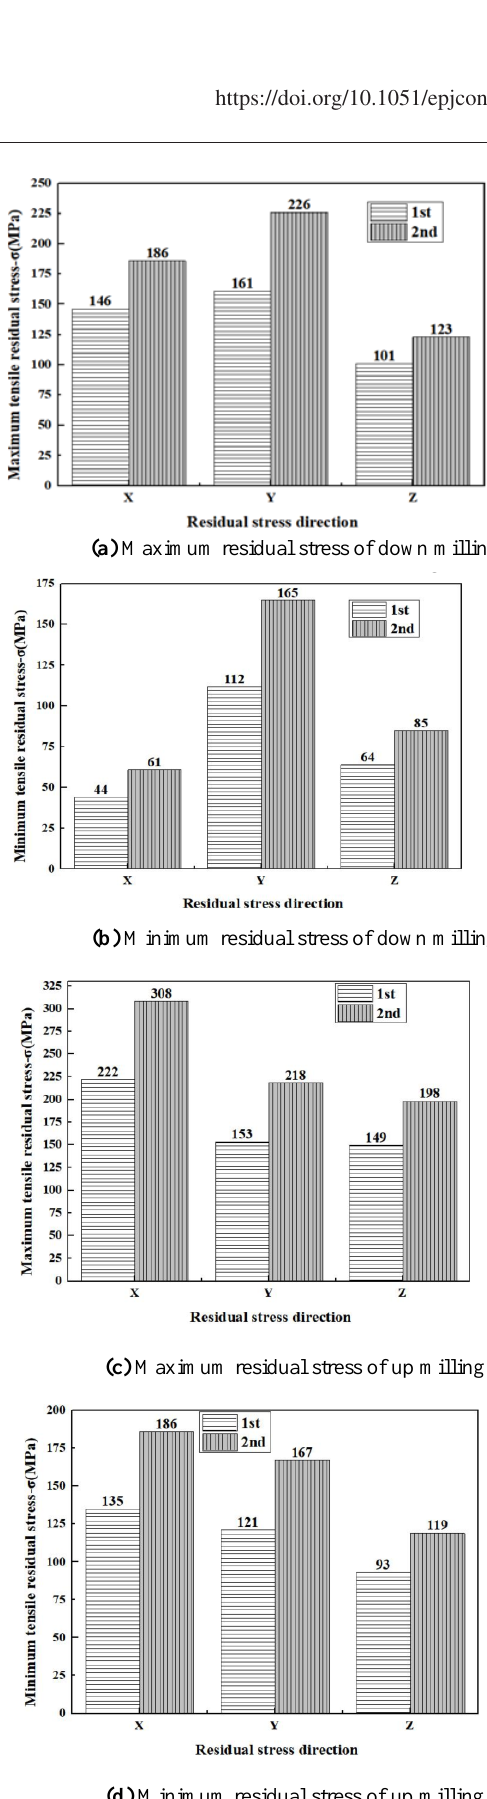
Fig.6. Curved surface residual stress superposition